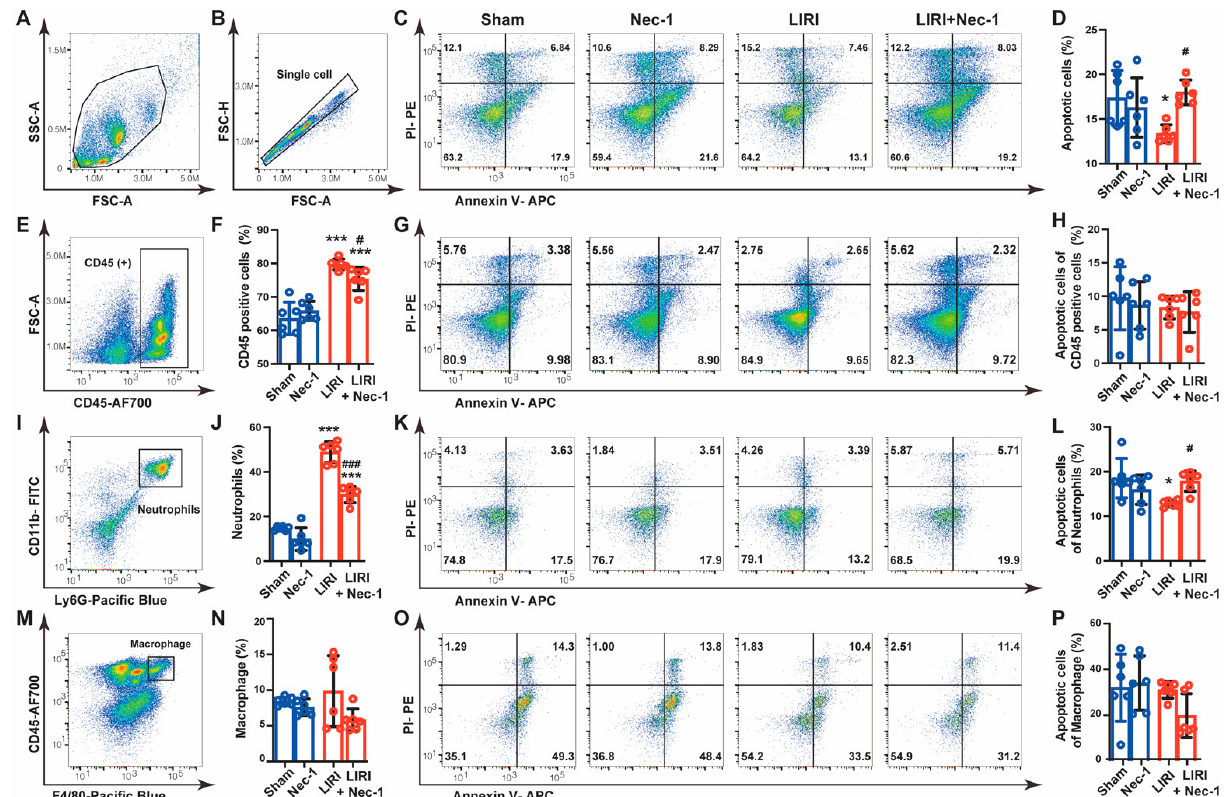
Figure 6. Necrostatin-1 promoted the apoptosis of neutrophils in mouse LIRI. The mouse LIRI was induced by clamping the left pulmonary hilum of the mouse for 1 h using a microvascular clip and then removing the clip for reperfusion for 2 h. Nec-1 (1 mg/kg) was administered intraperitoneal injection 1 h before ischemia. The left lung tissues were mechanically dissociated and subsequently digested, and then the single-cell suspensions were prepared from lung tissue. ( A , B ) Gating strategy delineating mouse lung single-cell suspensions. ( C ) Annexin V and PI staining of single cells prepared from mice lungs. Apoptotic cells were identified by Annexin V positive but PI negative cells. ( D ) Apoptosis rates of single-cell suspension in lung tissues. ( E ) Gating strategy delineating lung CD45+ subsets. ( F ) Percentage of CD45+ cells in total cells isolated from lung tissues. ( G ) Annexin V and PI staining of CD45+ cells in mice lungs. ( H ) Apoptosis rates of CD45+ cells. ( I ) Gating strategy delineating lung neutrophils subsets (CD11b + Ly6G + cells) in lung tissues. ( J ) Percentage of neutrophils in total cells isolated from lung tissues. ( K ) Annexin V and PI staining of neutrophils in mice lungs. ( L ) Apoptosis rates of lung neutrophils. ( M ) Gating strategy delineating lung macrophage subsets (F4/80 + CD11b + cells). ( N ) Percentage of macrophages in total cells isolated from lung tissues. ( O ) Annexin V and PI staining of lung macrophages. ( P ) Apoptosis rates of lung macrophages. n = 6 animals per group. * p < 0.05, ** p < 0.01, *** p < 0.001, compared with Sham; # p < 0.05, ## p < 0.01, ### p < 0.001, compared with LIRI; one-way